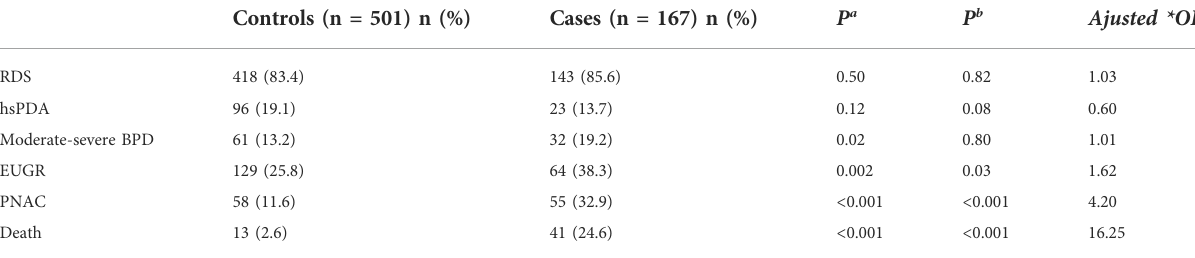
TABLE 5 Studies on the correlation between NEC and hospitalization